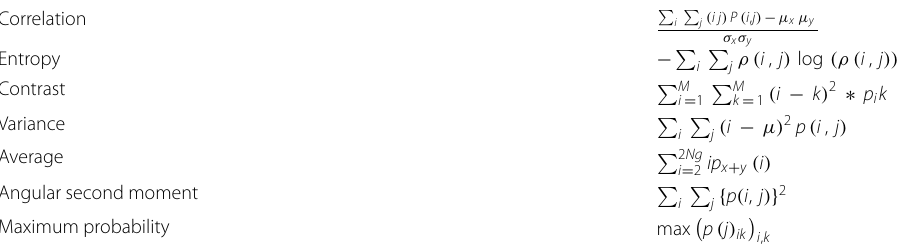
Table 1 Gray-level co-occurrence matrix